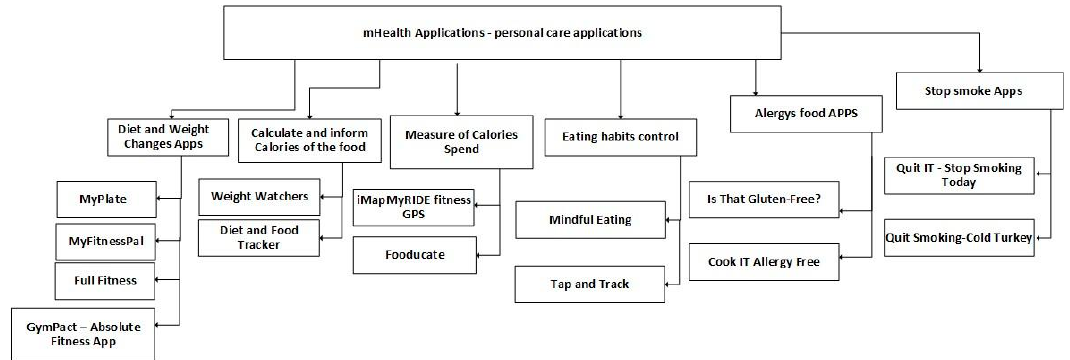
Figure 7. Classification of mobile health applications related to personal care.